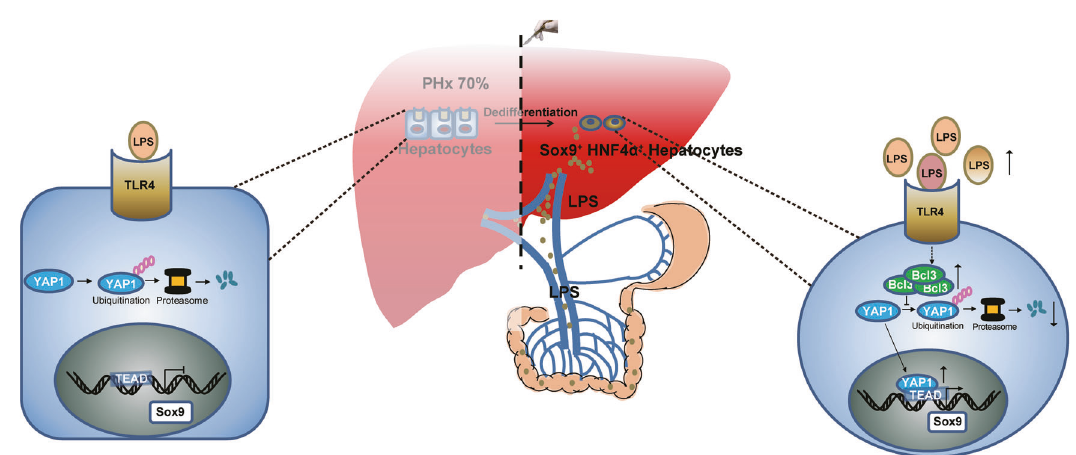
Fig. 6 Schematic representation of liver regeneration mediated by the LPS/Bcl3-YAP1 axis. LPS, derived from enteric bacteria, promotes liver regeneration by inducing the conversion of mature hepatocytes into Sox9 + HNF4 α + cells, which is mediated by the activation of Bcl3 and